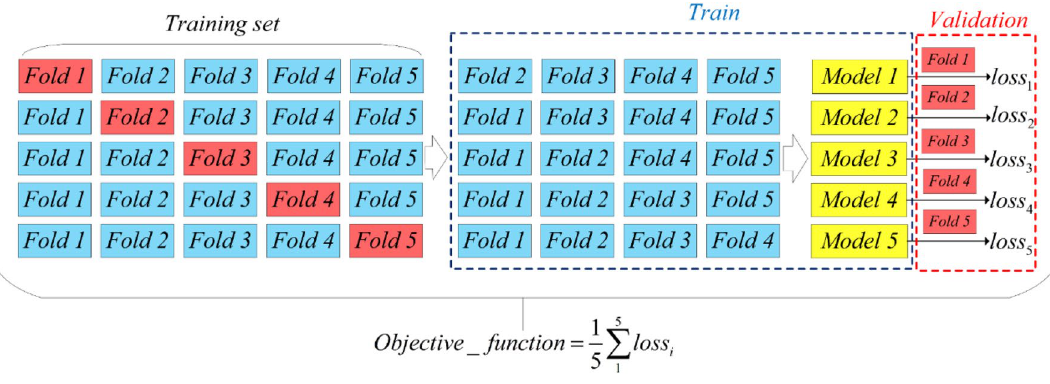
Figure 5. The calculation method of the objective